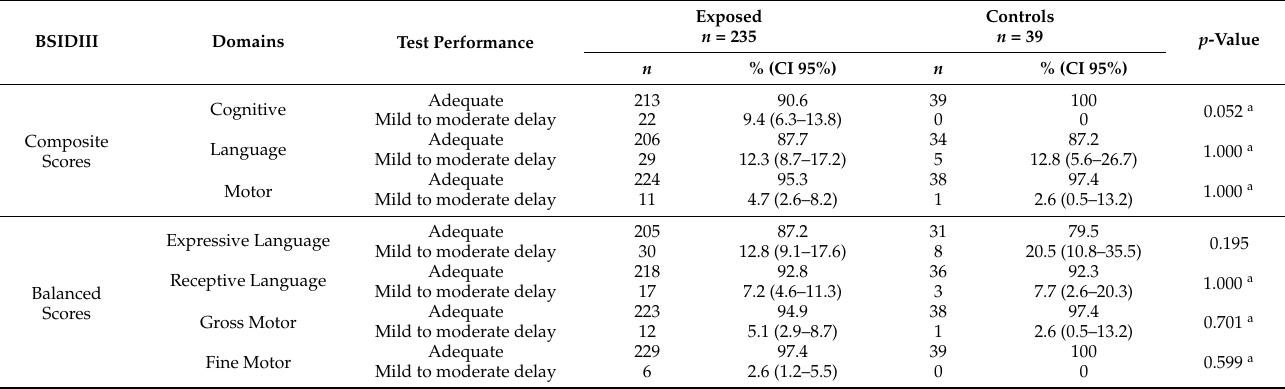
Table 2. Neurodevelopment of the group of children with prenatal exposure to ZIKV born without microcephaly and the group of controls based on BSIDIII composite and balanced scores.